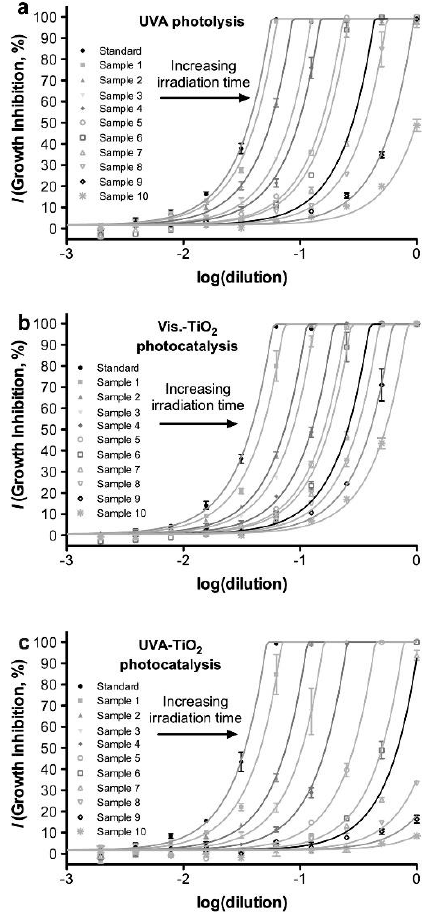
Figure 7. Dose–response relationships for deactivation of ciprofloxacin via ( a ) UV–A photolysis, ( b ) Vis-TiO 2 photocatalysis, and ( c ) UVA-TiO 2 photocatalysis in solutions initially dosed with 100 μM ciprofloxacin at pH 6, 25 °C, and 0.5 g/L TiO 2 (for photocatalysis experiments). The averages of triplicate experimental measurements are shown with corresponding 95% confidence intervals. The independent variable “dilution” is equal to 1/2n, where “2” is the serial dilution factor used in preparing dose–response series (i.e., for two-fold, or 1:1 dilution), and “n” the number of times a given sample has been serially diluted relative to the corresponding parent sample (i.e., 1/20 = 1 corresponds to the undiluted sample). Reprinted with permission from [63], copyright 2010, Elsevier.